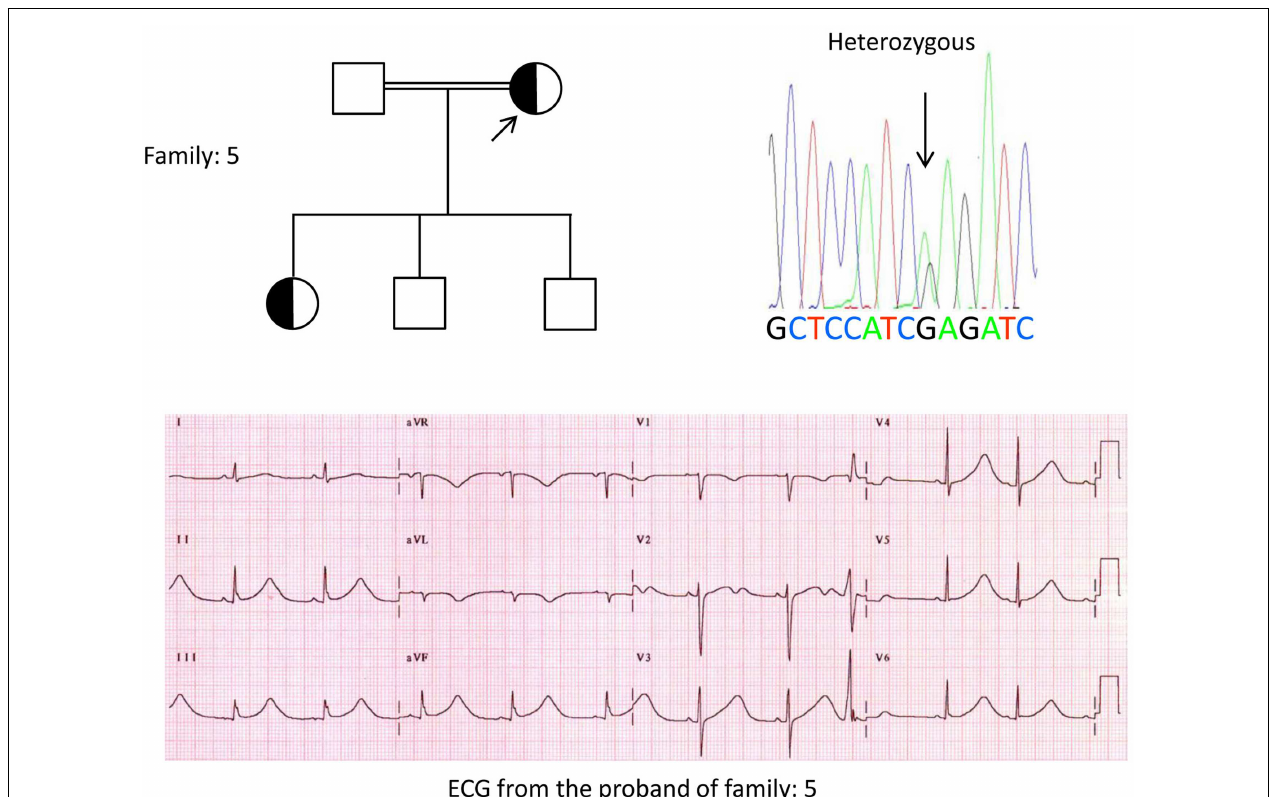
wave, QTc interval is 580ms. Screening of the KCNH2 gene shows substitution of nucleotide “G” for an “A” (c.2362G > A, arrow marked), which leads to amino acid substitution,